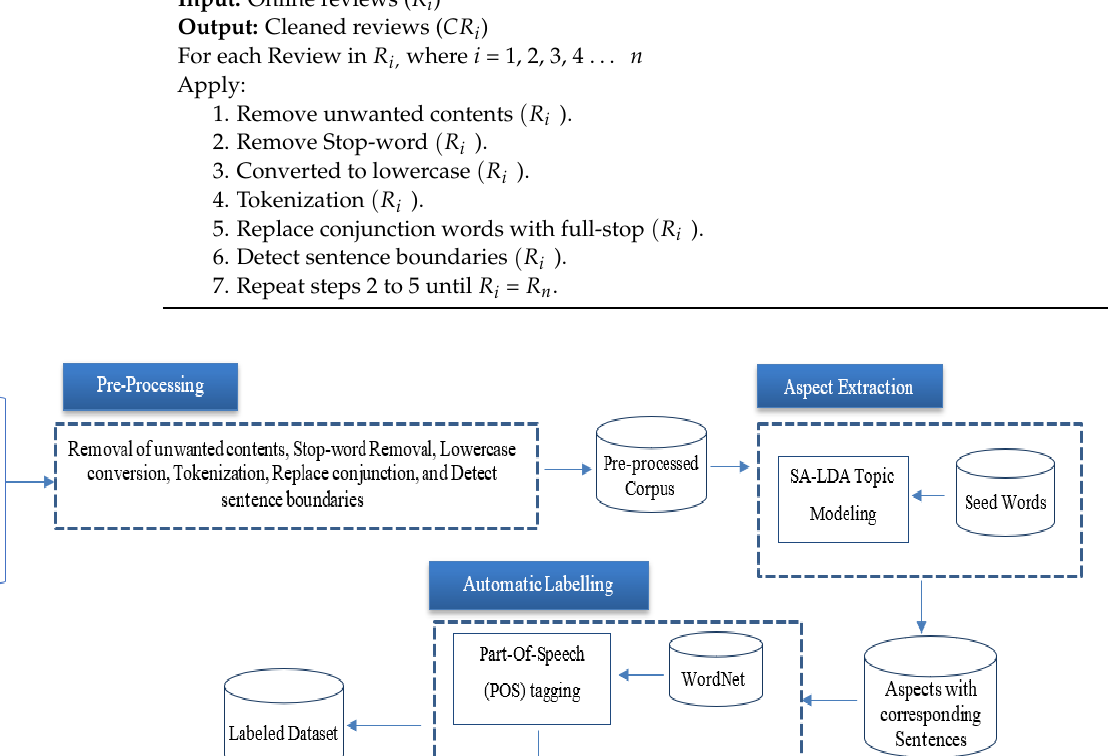
Table 1. Summary of the